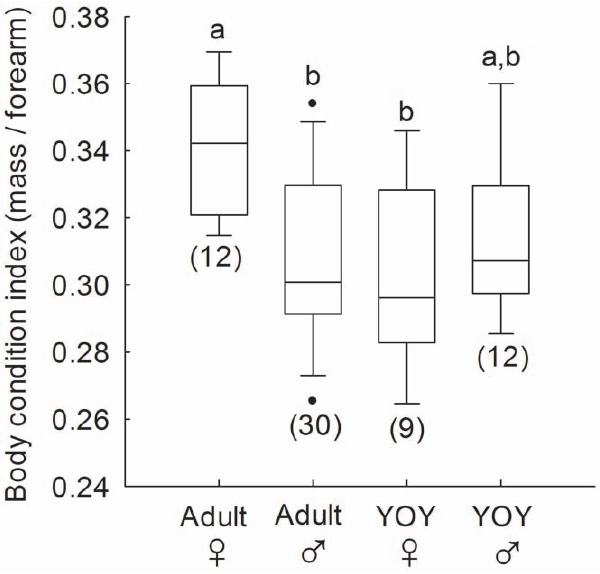
Figure 1. Body condition indices of bats during fall swarming. Bats were captured from 15–19 Sept 2009 at the entrances of Abyss, Dale’s, Firecamp and Microwave caves. Numbers in brackets indicate sample size and boxes sharing the same letter are not significantly different from each other. Boxes depict the 25 th and 75 th percentiles, lines within boxes mark the median, whiskers represent 95 th and the 5 th percentiles and dots indicate outliers.